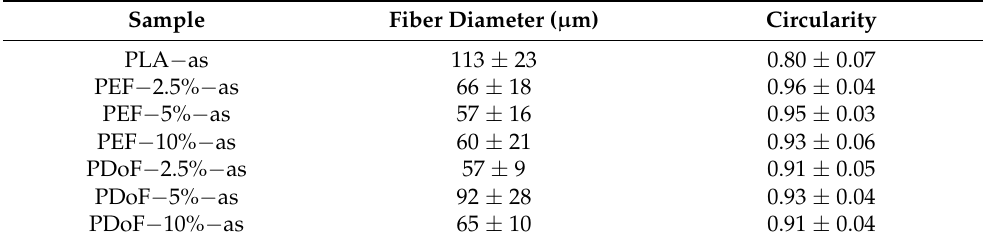
Figure 2. LM micrographs of the polished cross − section of the as − spun fiber blends ( a ) PLA, ( b ) PEF − 2.5% − as, ( c ) PEF − 5% − as, ( d ) PEF − 10% − as, ( e ) PDoF − 2.5% − as, ( f ) PDoF − 5% − as, ( g ) PDoF − 10% − as. Table 2. Diameter and circularity of the as − spun fibers.